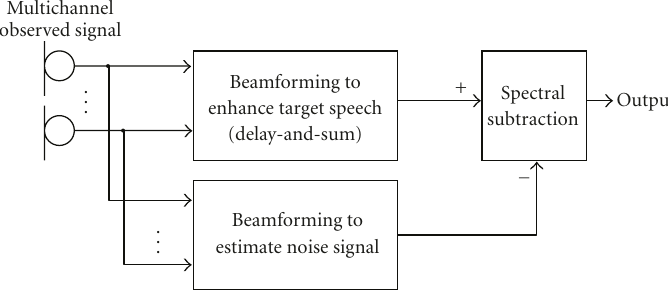
Figure 1: Block diagram of architecture for spectral subtraction after beamforming (BF+SS).